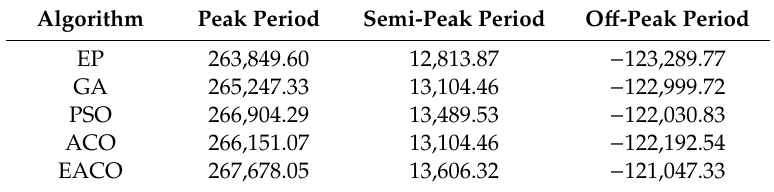
Table 8. Comparison of EP, GA, PSO, ACO, and EACO algorithms. Unit: NT$ /